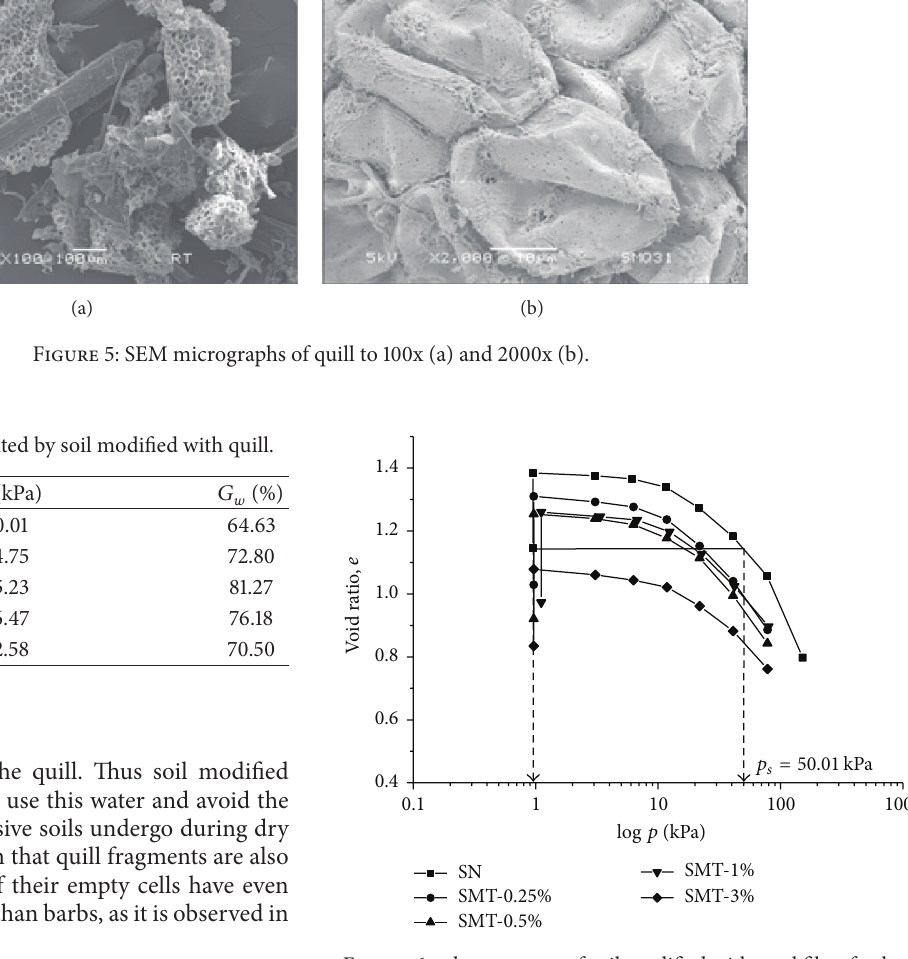
Figure 6: 𝑒 -log 𝑝 curves of soil modified with total fiber feathers.